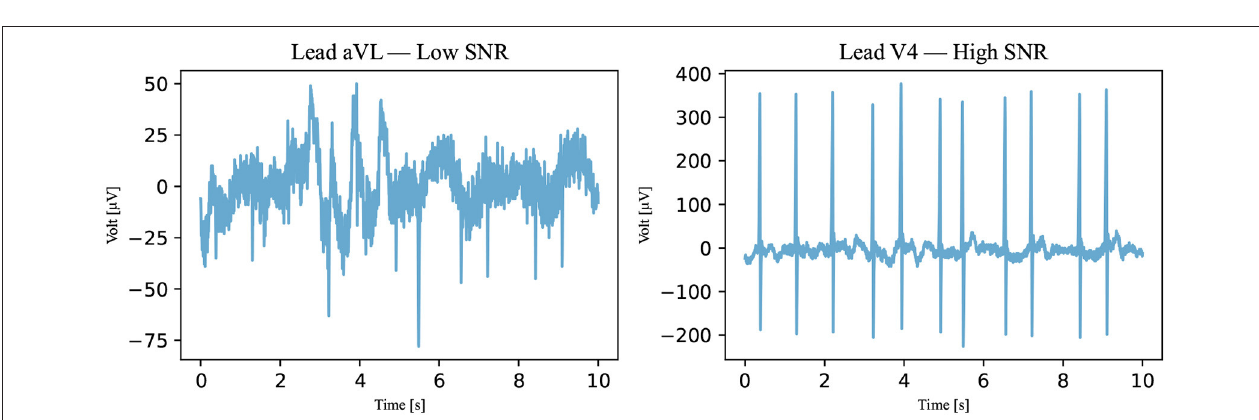
FIGURE 7 | An SNR example. With respect to Algorithm III, an example of a not-passed signal is on the left and an example of a passed signal is on the right (Recording 1896934). The SNRs of the signals are 0.4384 dB for the signal on the left and 8.1156 dB for the signal on the right.